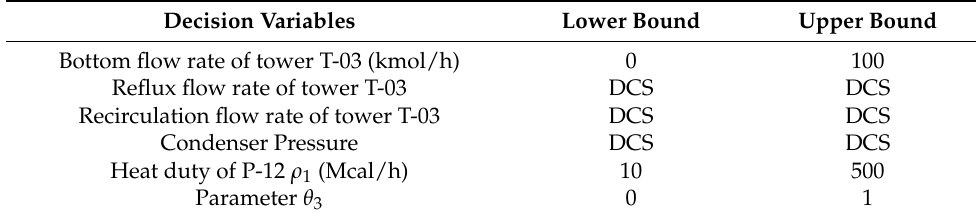
Table 4. Decision variables of the Optimization Problem.